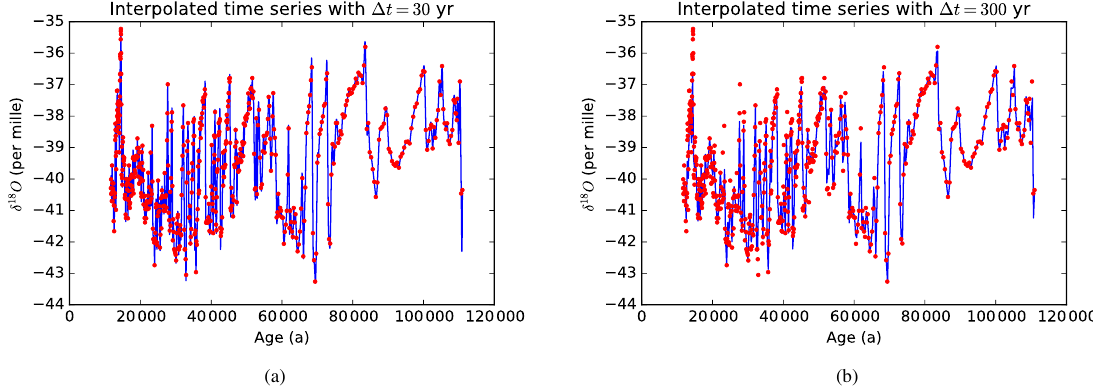
Figure F1. δ 18 O signal from the GISP2 ice core (Grootes and Stuiver, 1997), for which the first 11kyr are removed. Raw (red dots) and interpolated (blue line) time series, with (a) (cid:49)t = 30yr and (b) (cid:49)t = 300yr.